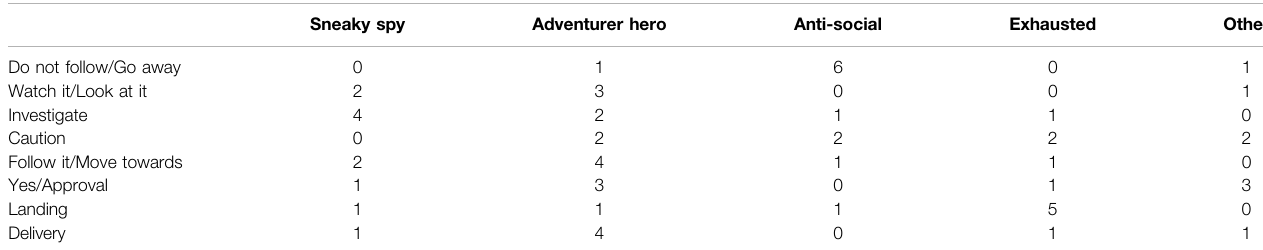
TABLE 10 | Applied